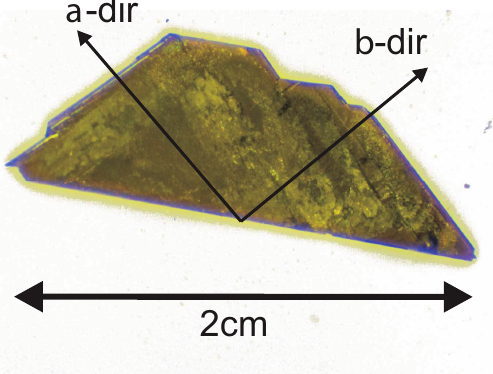
Figure 5. Photograph of a naturally grown TTF-CA single crystal which was grown by the plate sublimation method. The shape is trapezoidal with a dimension of 1 mm × 2 mm. The a - and b -direction are perpendicular to the short edges of the crystal. The crystallographic axis are determined by polarized infrared